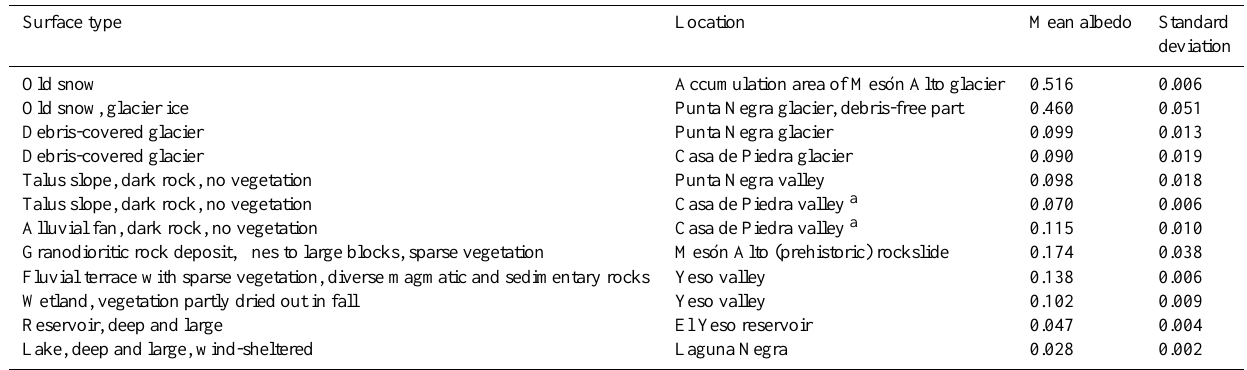
Table 1. ASTER-derived broadband surface albedo values of selected homogeneous test surfaces in and near the study area. Surface